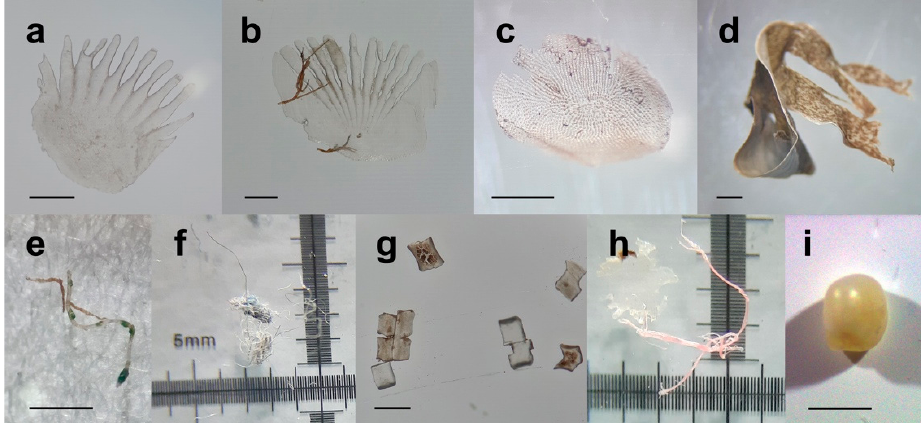
Figure 3. Items identified in Mediterranean monk seal recovered in Albania: ( a ) sea bass scale, ( b ) (possible) sea bream scale, ( c ) garfish scale, ( d ) Posidonia, ( e ) piece of nylon net, ( f ) lump of fibres (cellulose), ( g ) pieces from unknown origin (possibly pieces of fish spines), ( h ) pink fibre (polymer identification not carried out), and ( i ) pearl (scale bar: 1 mm).